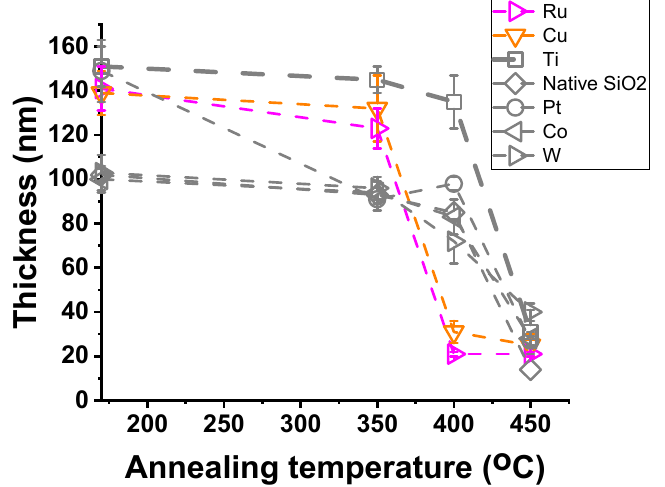
Figure 6. Thicknesses of polyimide films remaining on different surfaces after annealing for 30 min under N 2 atmosphere. Curves for the most catalytic surfaces (Ru and Cu) are shown in colours, while those for inactive surfaces and surfaces comparable to SiO 2 are in grey.